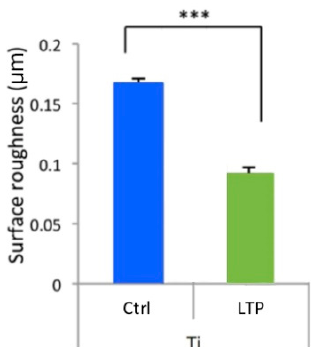
Figure 4. The effect of various treatments on the surface roughness of titanium disks. Roughness was lower in the disks treated with low-temperature plasma (LTP; LTP-Ti condition), indicating that they had smoother surfaces than the control (Ctrl-Ti) disks. * p < 0.05, ** p < 0.01, *** p < 0.001.